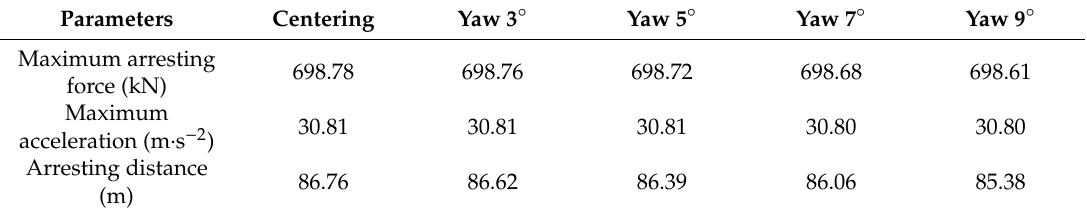
Table 4. Comparison of performance of the arresting system of different eccentricity.